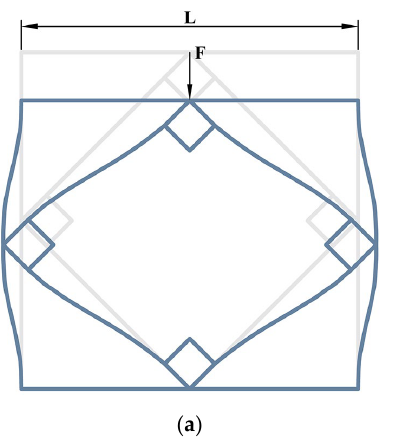
Figure 5. The deformation mechanism diagram and geometric parameter of the rigid unit cell: ( a ) Deformation mechanism of the rigid cell under an external load; ( b ) The beam section size of the rigid cell (L = 70 mm).